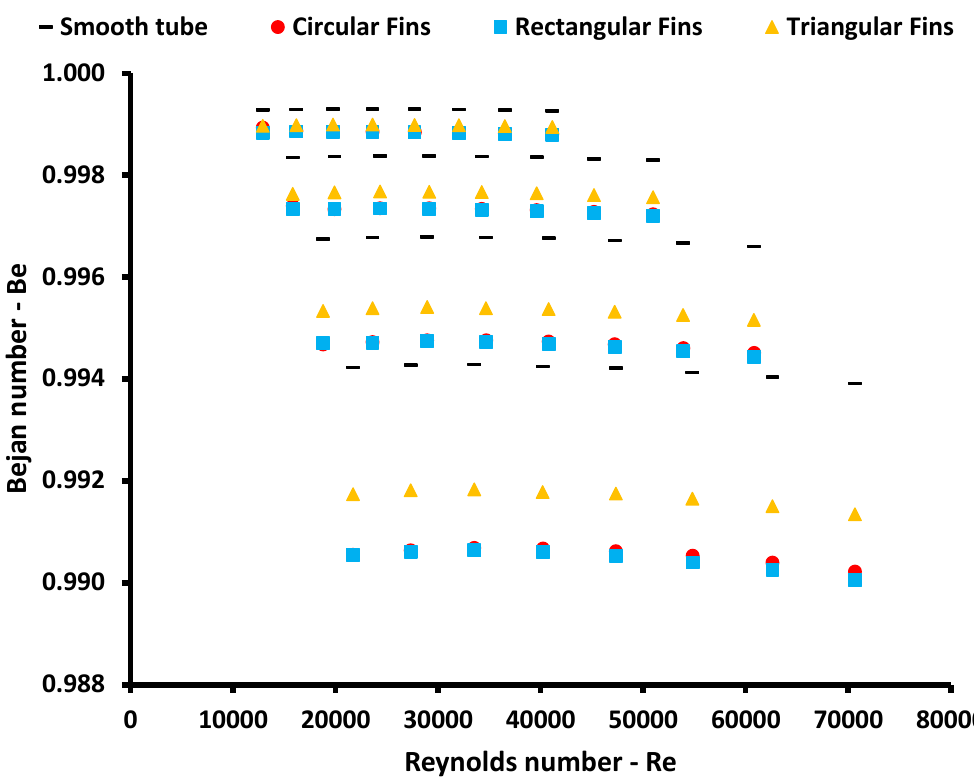
Figure 19. Bejan number in the examined cases for all the tubes.